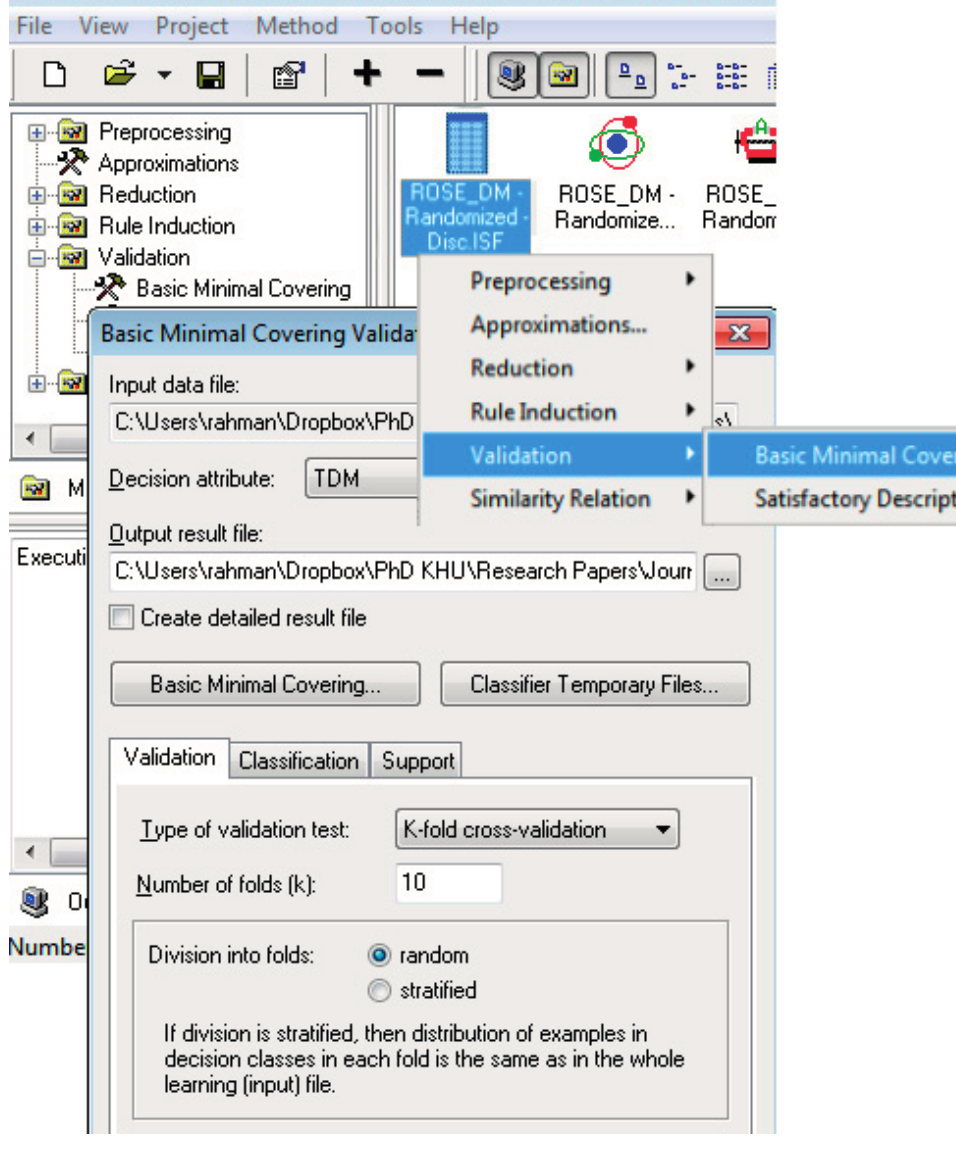
Figure A4. The validation process in the rough set data exploration system (ROSE 2) system for validating and testing mined